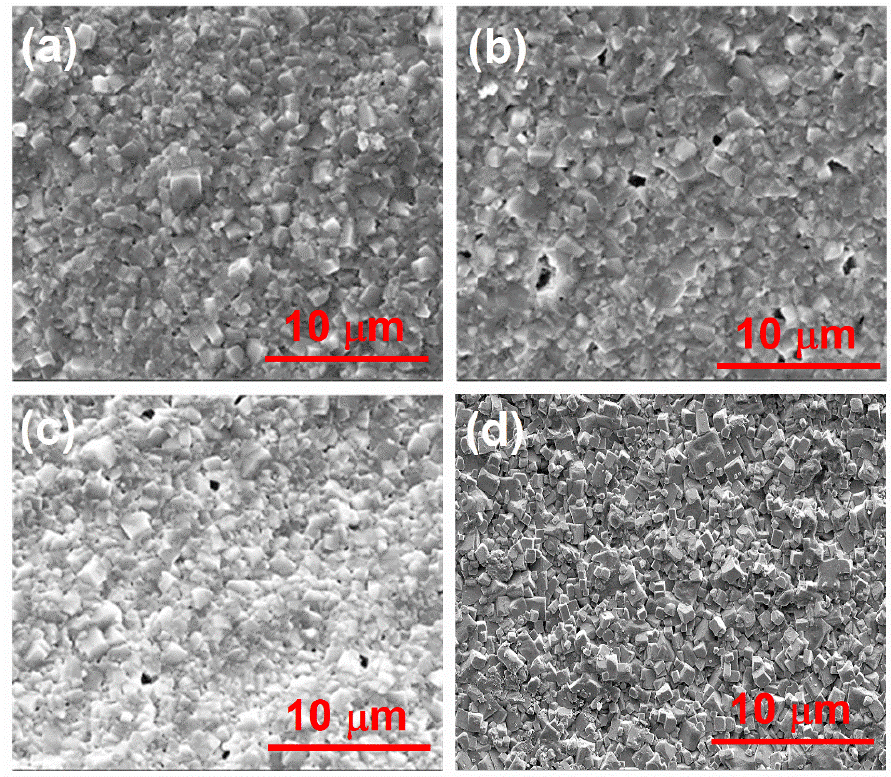
Figure 2. Surface morphologies of 0.92KNLN-0.08BZ ceramics prepared using ( a ) single-step, ( b ) 2-step, ( c ) 3-step/5 h and ( d ) 3-step/20 h sintering methods.